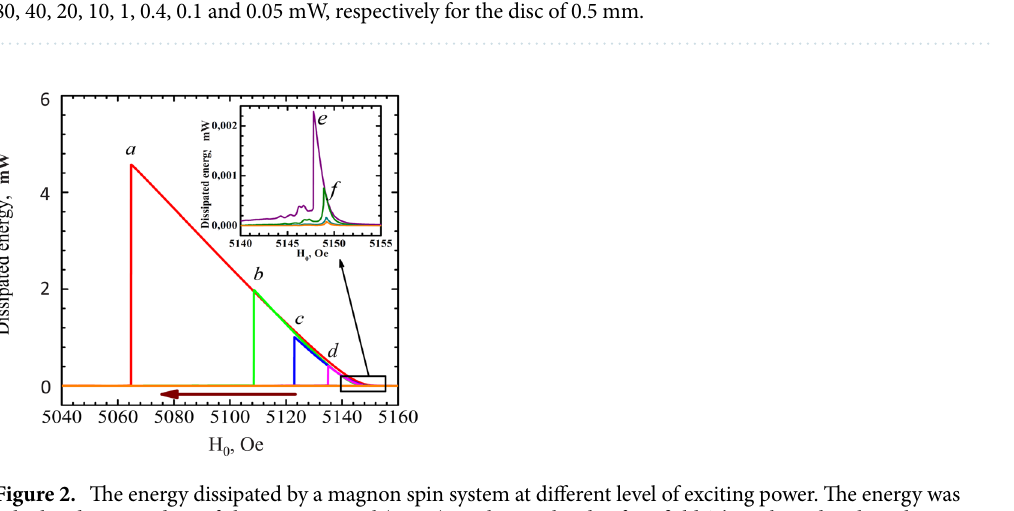
Figure 1. Amplitude of the absorption signal at different RF pump power in a decreasing magnetic field. The enlarged scale is shown in the inset. Here and in the next figures signals marked a–h corresponds to RF power of